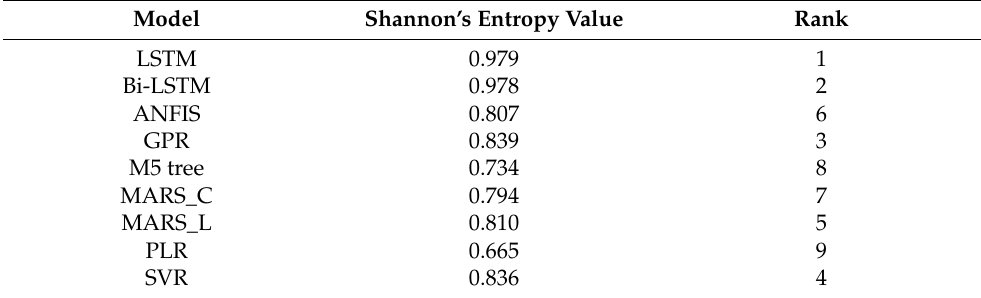
Table 8. Shannon’s entropy values for different models and their corresponding ranks. Model Shannon’s Entropy